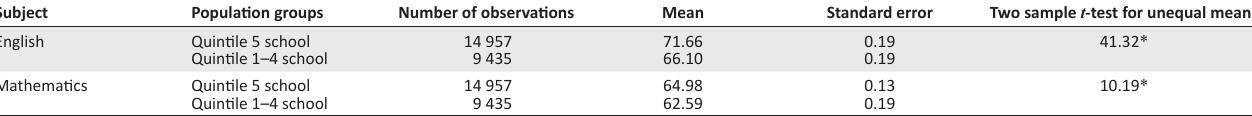
TABLE 3: Two sample test results for comparing the Mathematics and English results of quintile 5 schools with quintile 1–4 schools (assuming unequal variances in the grouped populations).